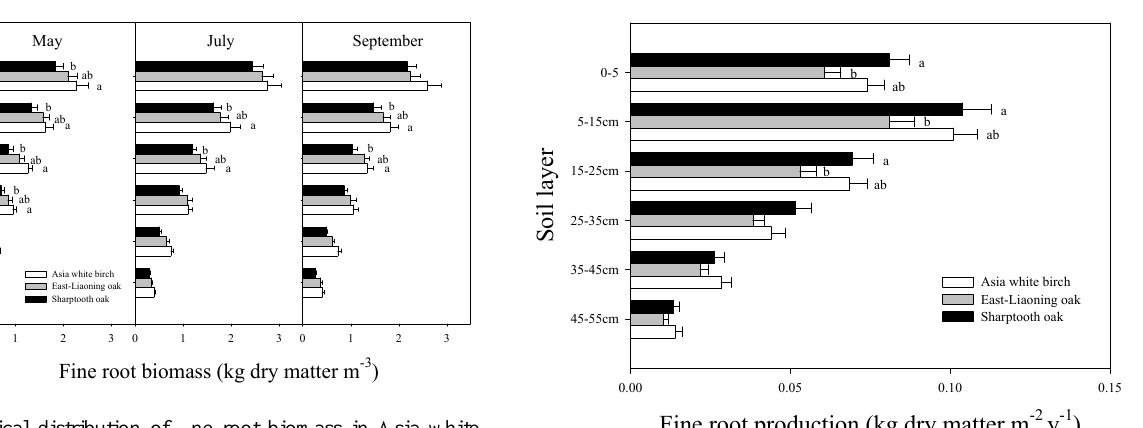
Fig. 5. Vertical distribution of fine root biomass in Asia white birch and East-Liaoning oak forests of warm temperate zone and Sharptooth oak forest of sub-topical zone in May, July and Septem- ber 2006. Horizontal bars indicate standard errors of means ( n =5). Different letters within a soil layer are significantly different ( P < 0.05) according to the least significant difference test. Absence of letters implies that no significant differences were detected.